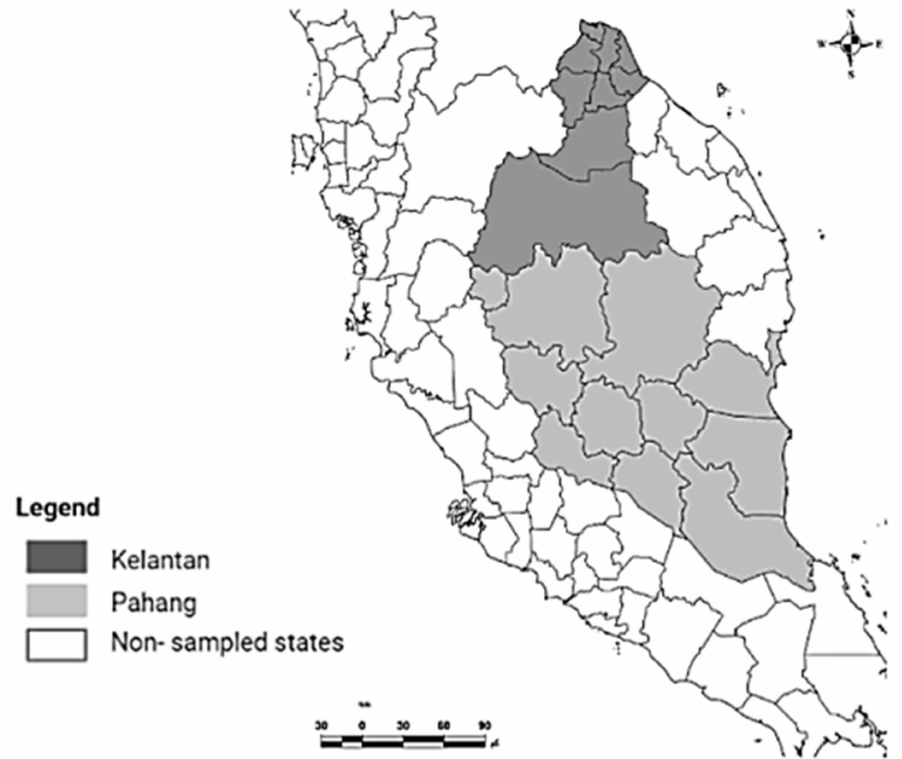
Figure 1. Map of the study area. The samples were collected from dairy farms in Kelantan and Pahang, East Coast of Peninsular Malaysia. The map was created using ArcGIS v. 7 (Esri Inc., Redlands, CA,